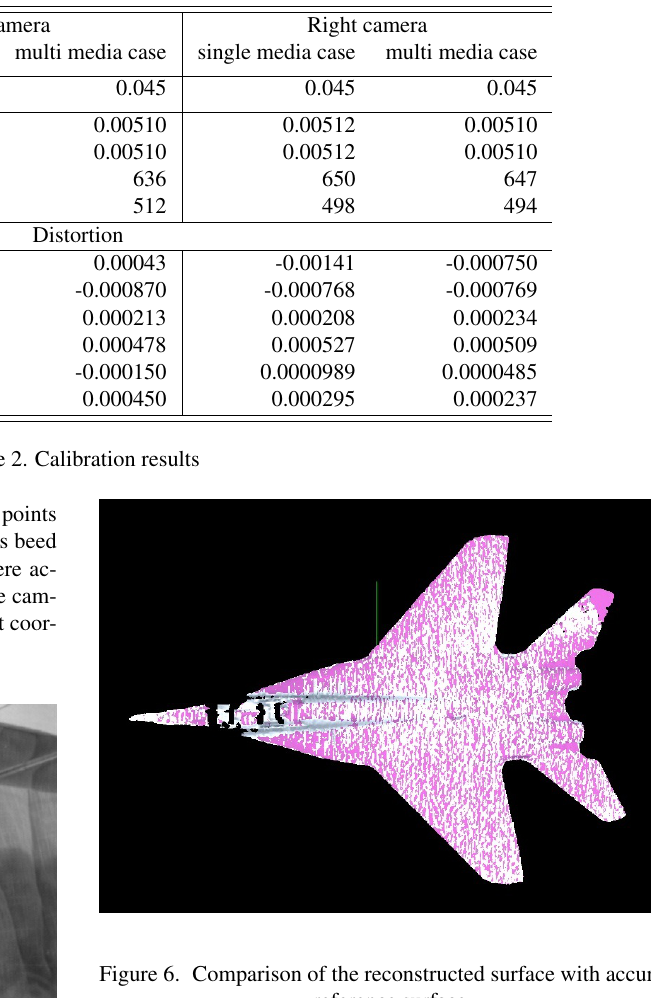
Figure 6. Comparison of the reconstructed surface with accurate reference